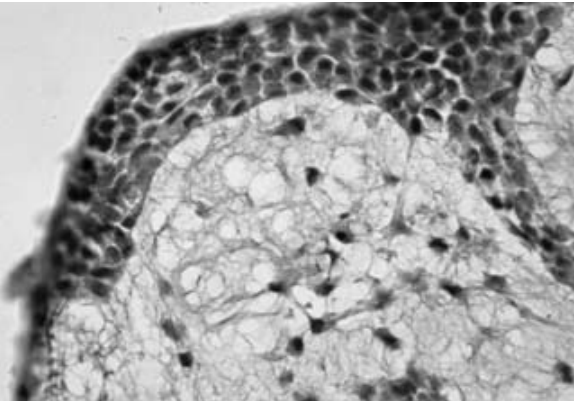
Figura 2 – Imunomarcação para p53 em células cúbicas (400x)